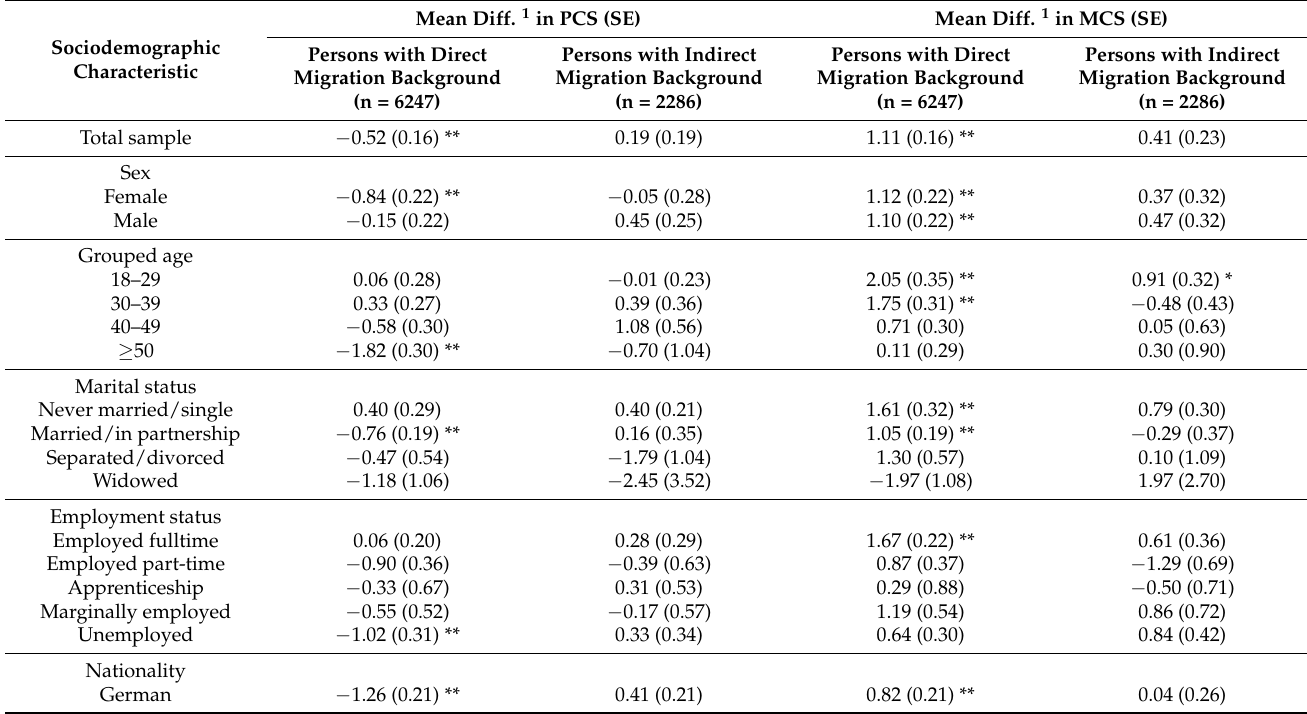
Table 3. Differences in PCS and MCS scores by sociodemographic characteristics between persons with direct/indirect and without migration background (survey years 2014 and